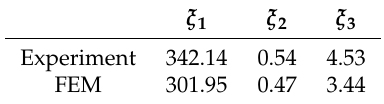
Table 1. Coefficients ξ 1 , ξ 2 and ξ 3 for experiment and FEM